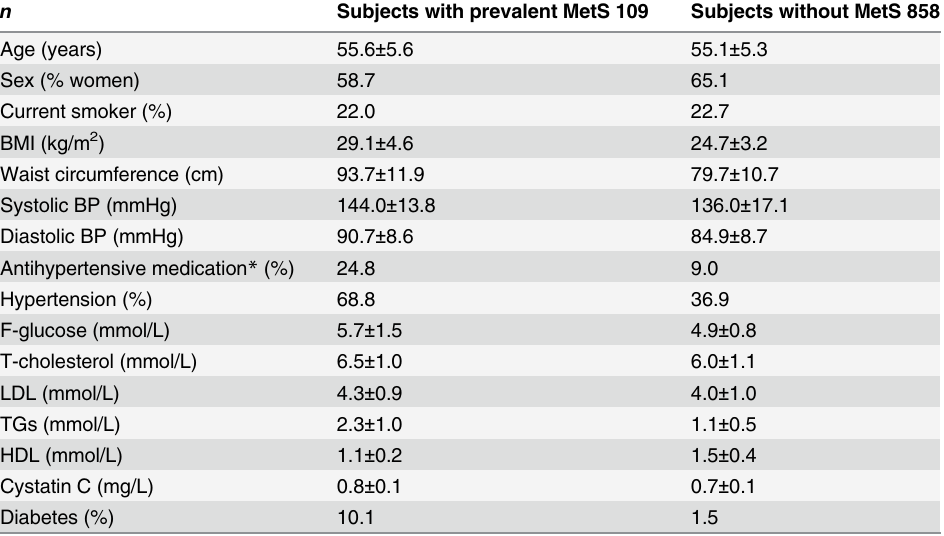
Table 1. Baseline characteristics of the study participants in the MDC-CC-re-examination-replication- cohort by prevalence of the metabolic syndrome.